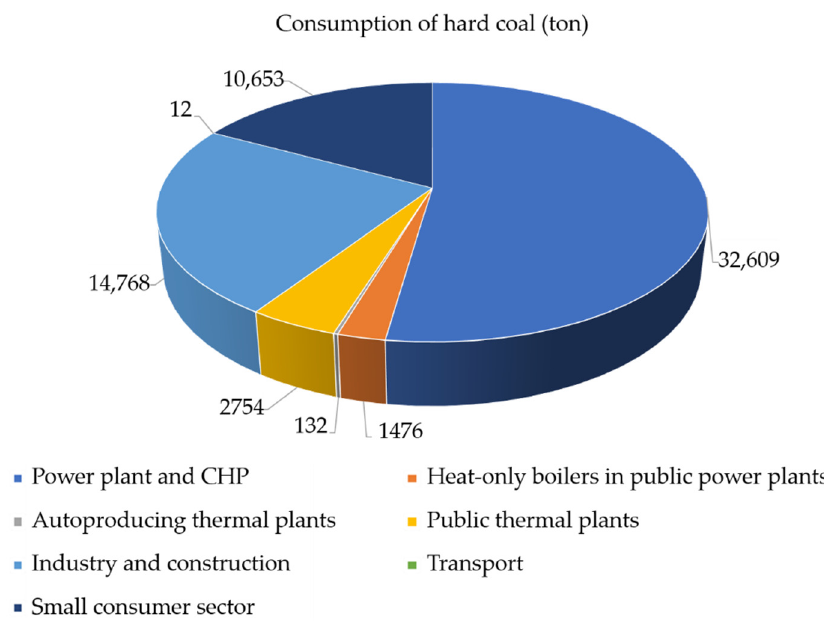
Figure 8. Distribution of coal consumption in Poland in 2020.